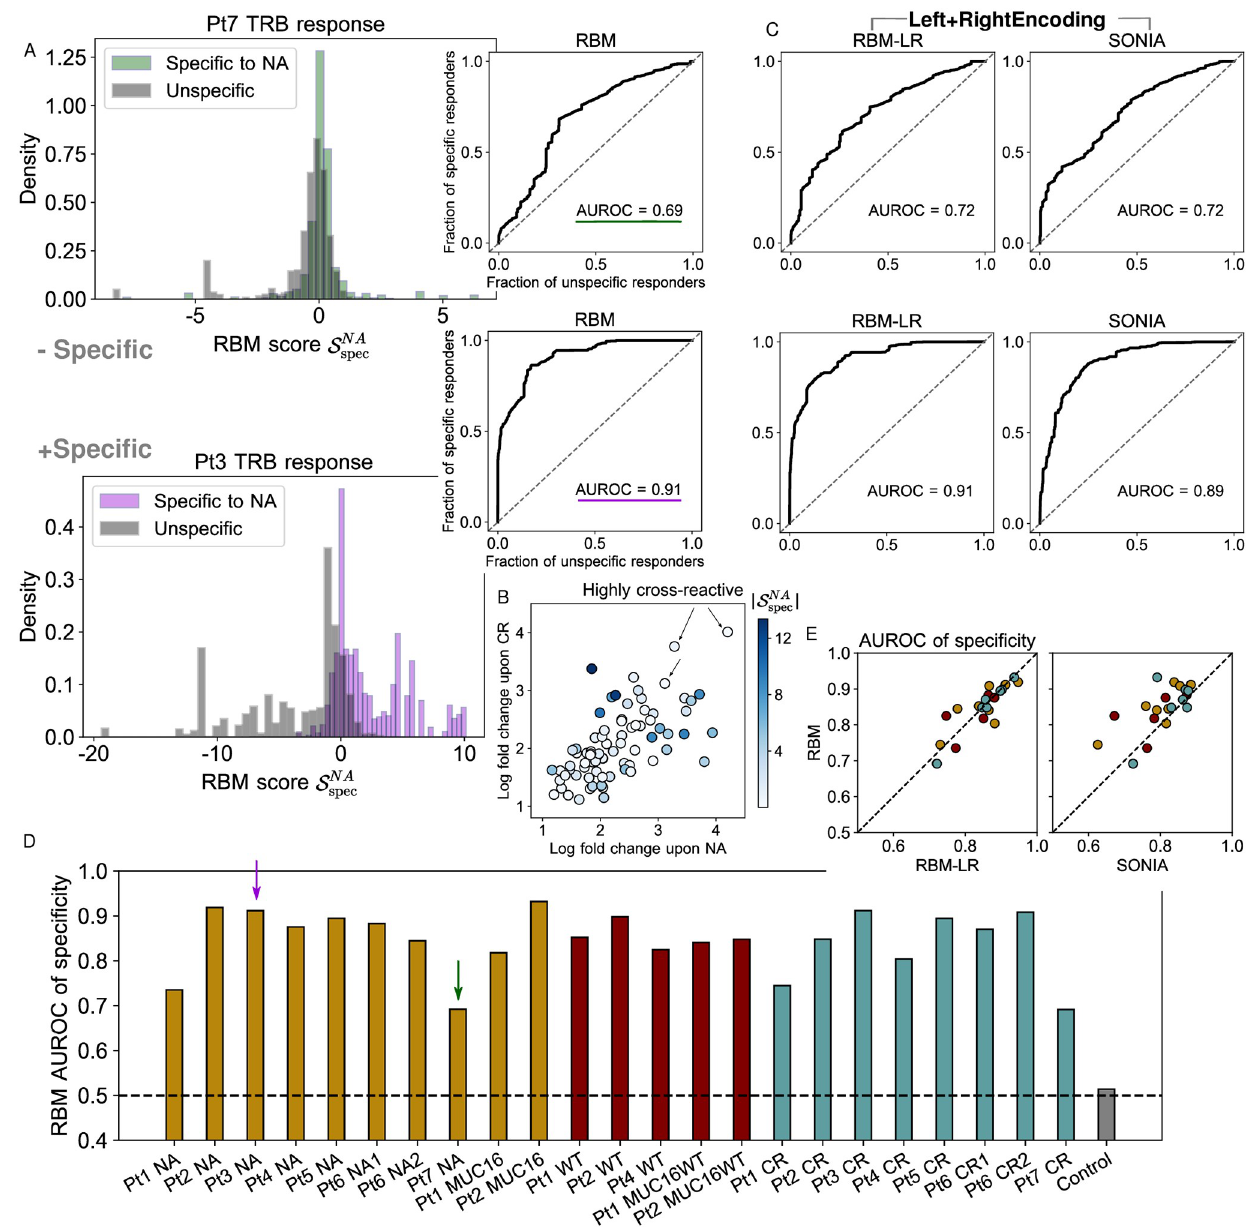
Fig 4. Model scores of T-cell response specificity. A: Histogram of RBM specificity scores S p showing their ability to discriminate specific responders to spec p = NA (assigned positive values) from unspecific ones (assigned negative values), for two examples: of less specific (Pt7 samples, top), and more specific expansion (Pt3 samples, bottom). ROC curves give the fraction of specific responders to p = NA (clones specifically expanded upon NA stimulation) predicted by S NA against the fraction of unspecific responders (clones responsive to the alternative stimulation, here CR) when varying the threshold of spec discrimination. The Area Under the ROC curve (AUROC) is taken as quantitative measure of specificity of expansion. B: Ref. [16] identified 78 clones that expanded under the stimulation by both NA and CR in Pt3. x and y -axis give their log fold change in the NA and CR experiments. The color code gives their specificity score S NA in absolute value (note that j S NA j ¼ j S CR j ). High j S NA j is assigned only to clones whose expansion was more significant in one spec spec spec spec experiment than in the other, while clones that are significantly expanded in both experiments (highly cross-reactive) are assigned j S NA j closer to zero. spec and log fold change are given in log base 10. C: ROC for Pt7 and Pt3 These clones do not contribute to discriminating the two repertoires. In A-B, S NA spec samples obtained by RBM-LR and SONIA, which take input training data in the Left+Right encoding. D: AUROC calculated from the RBM for all datasets under consideration from [16]. The dashed line gives the expected value (AUROC = 0.5) when comparing statistically indistinguishable samples (the “control”, gray bar), calculated from two replicates of Pt7 sample at day 0. E: Comparison of the AUROC obtained by the RBM, the RBM-LR model and SONIA for all datasets in D.